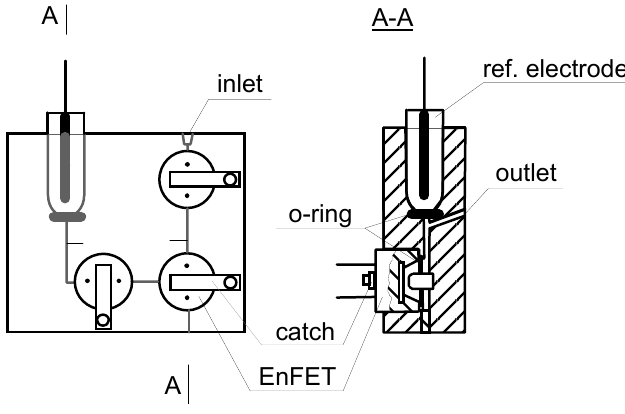
Figure 1. Schematic diagram of the serial flow-through